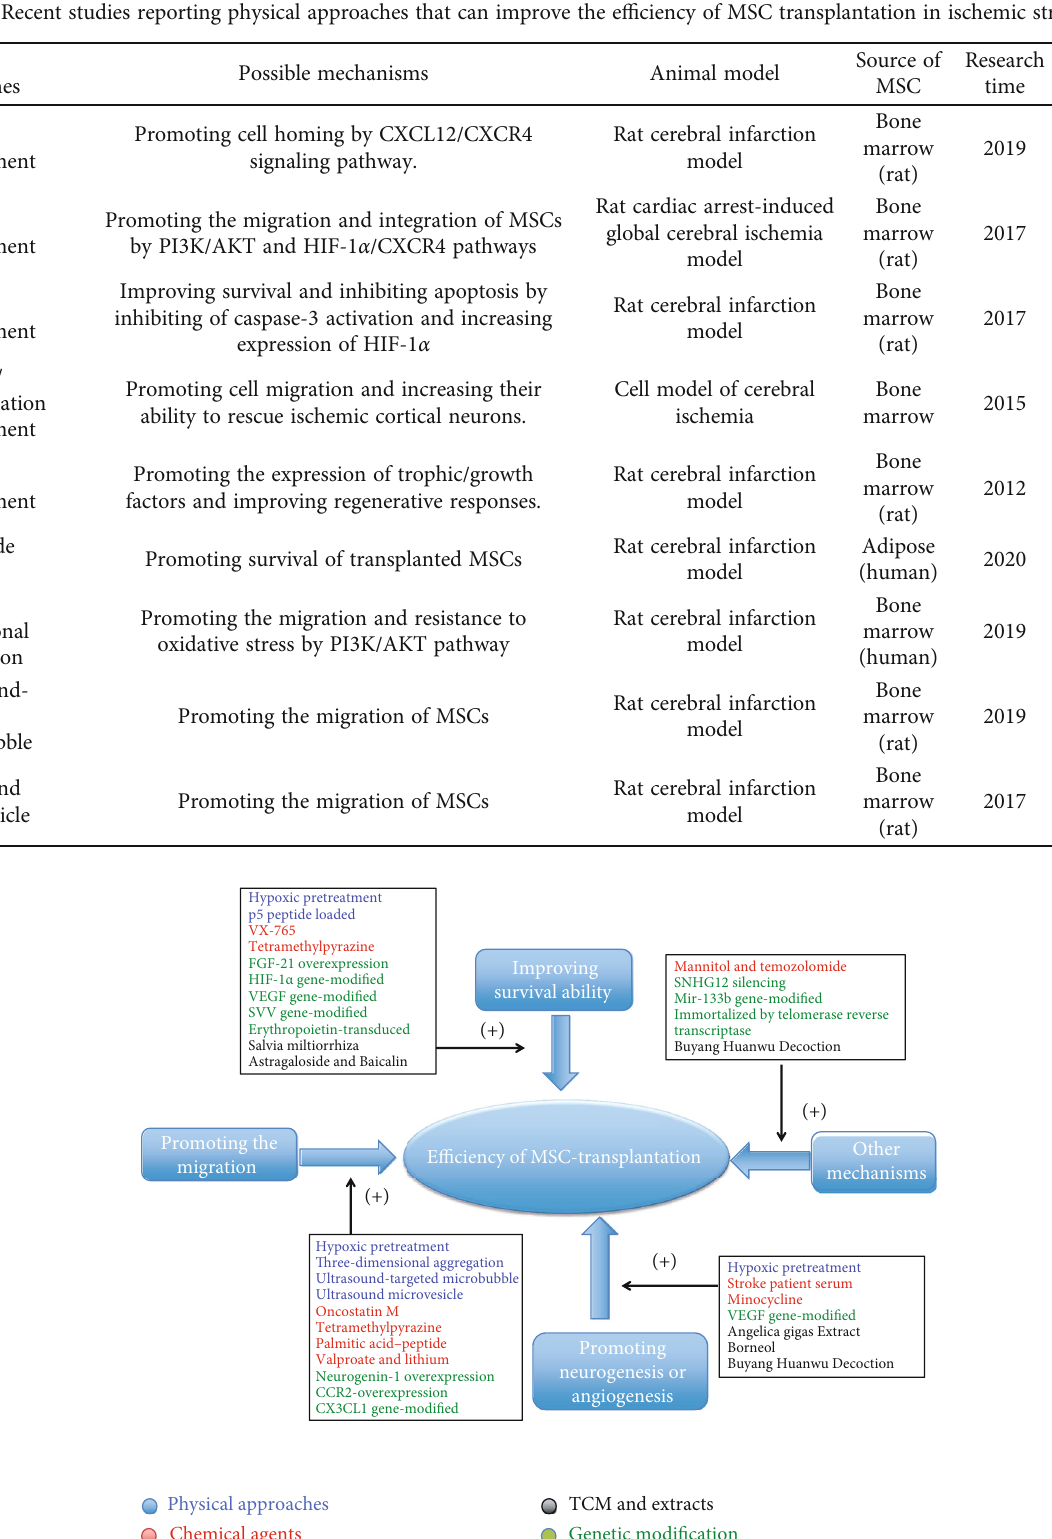
Figure 1: Possible main mechanisms of strategies to improve e ffi ciency of MSC transplantation in ischemic stroke